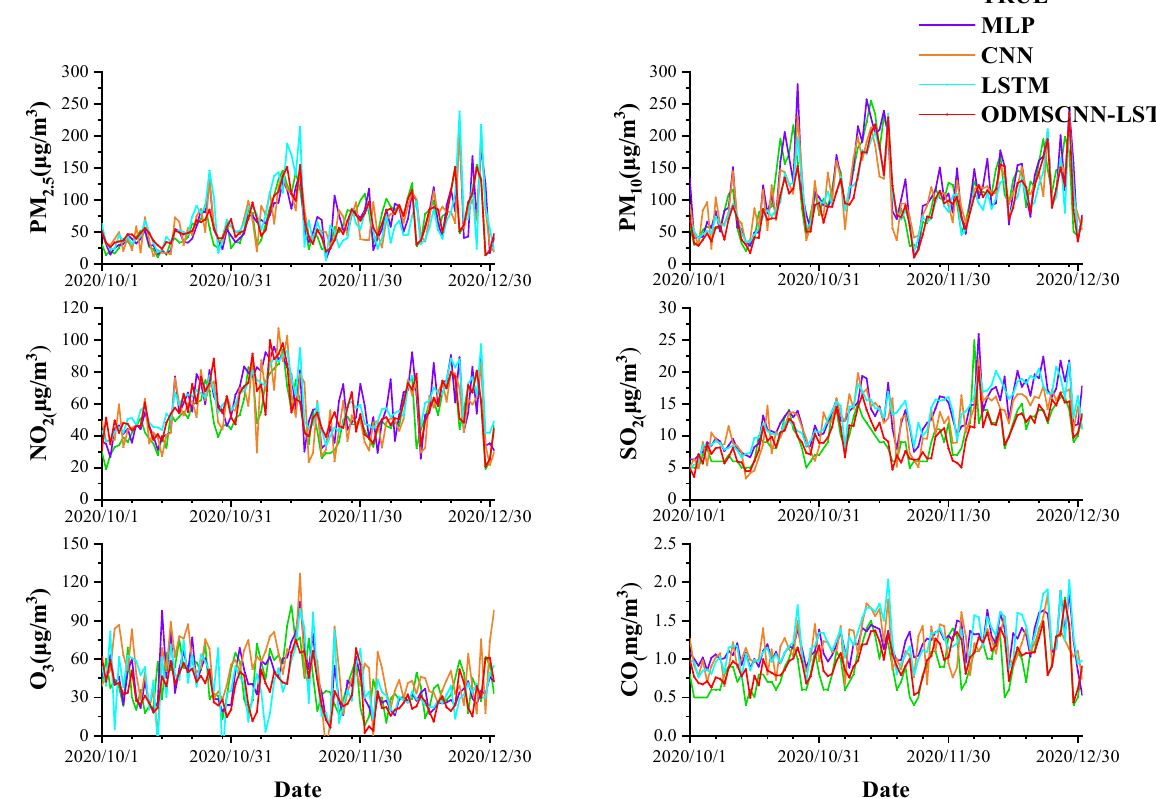
Figure 7. Comparison of daily data results of four different prediction models.